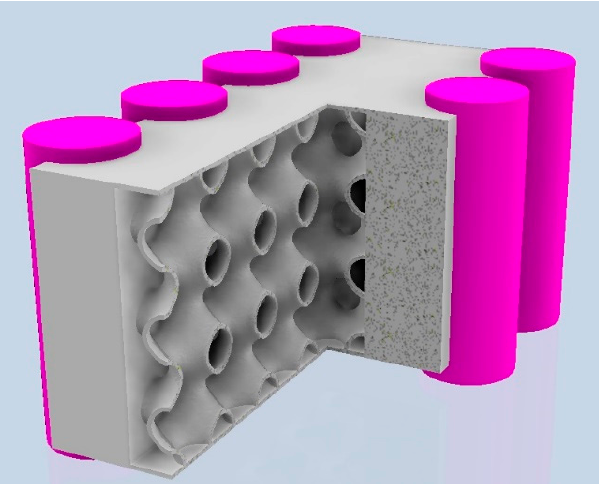
Figure 13. Cross-section of the channel shaping the flow of water cooling the battery pack—pictorial drawing.